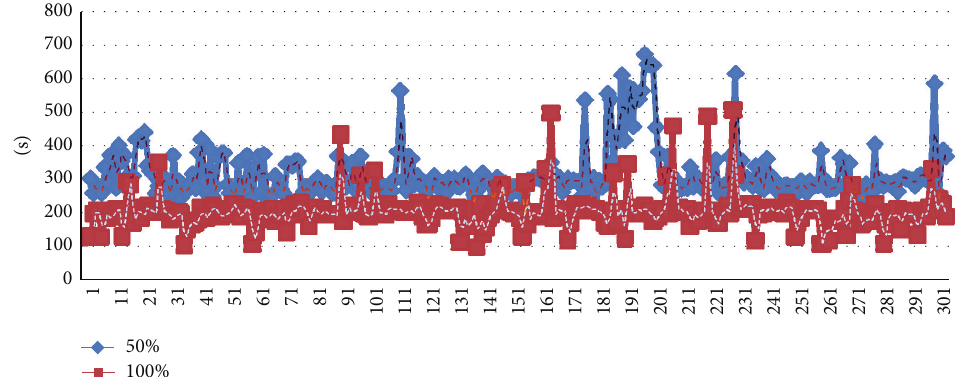
Figure 5: Comparison of average travel time under 17000 veh network